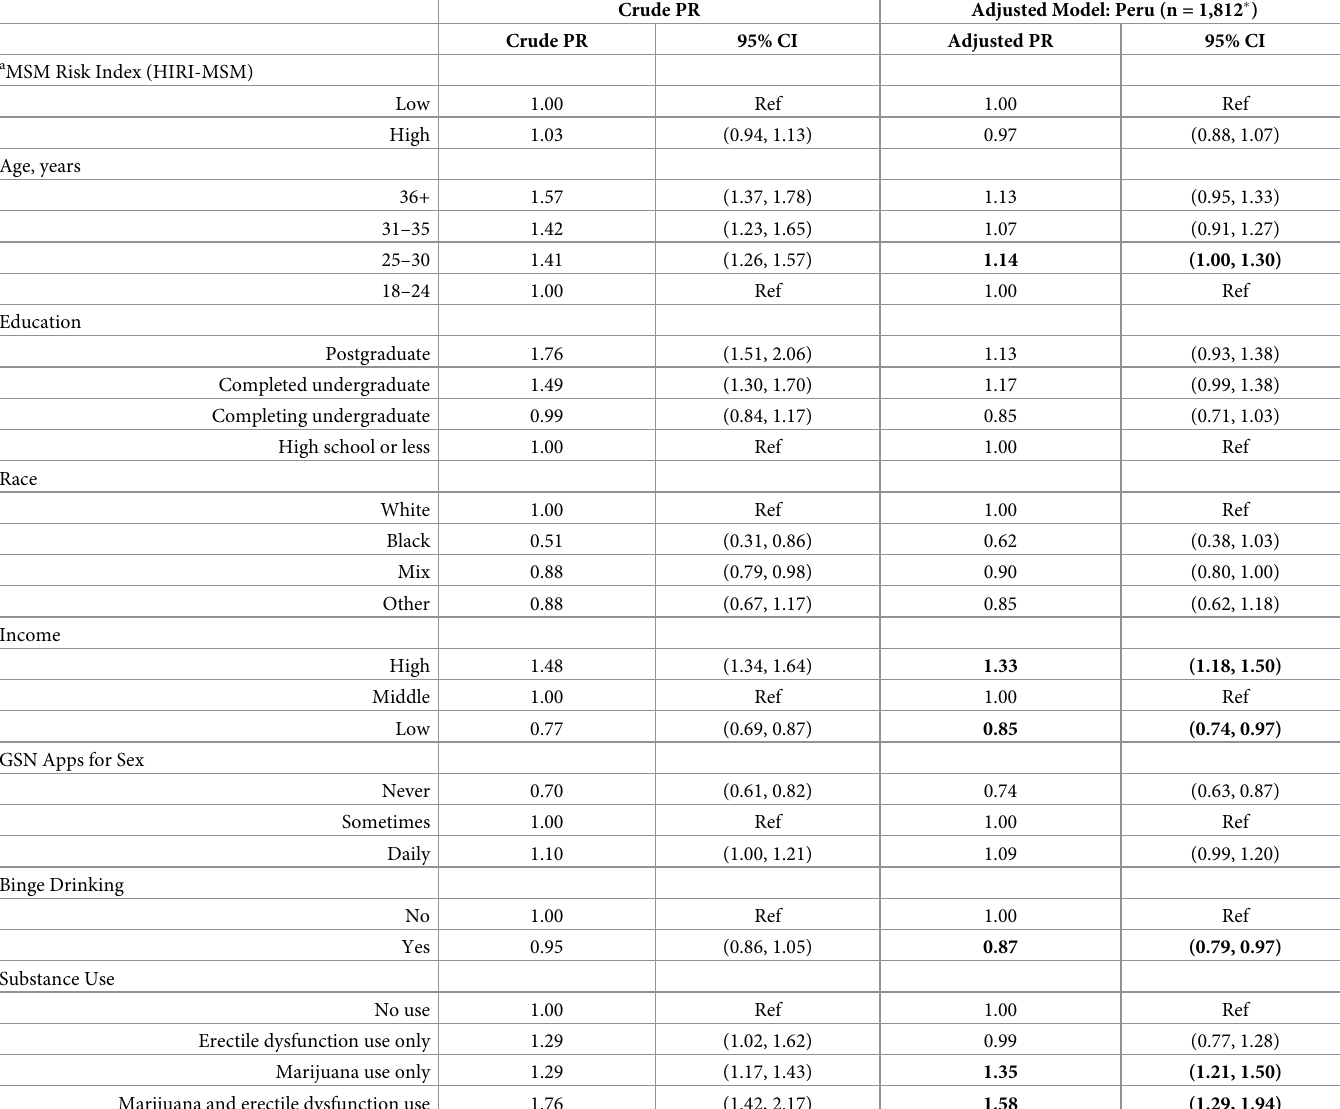
Table 4. PrEP awareness among MSM in Peru, crude and adjusted prevalence ratios (n = 2,150) April,